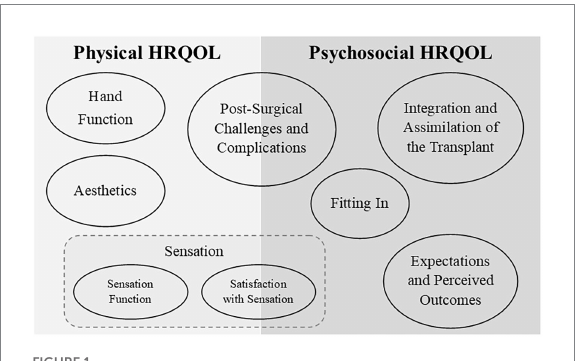
FIGURE 1 The eight new HRQOL content domains are presented above— represented by ovals—grouped into the overarching area of physical and psychosocial HRQOL under which they fall. In the area of physical HRQOL, three domains relevant to satisfaction with transplant were identified: Hand Function, Aesthetics, and Sensation. Sensation was further subdivided by separating Sensation Function from Satisfaction with Sensation. One domain includes aspects of both physical and psychosocial HRQOL: Post-Surgical Challenges and Complications, which includes physical and emotional reactions post-surgically. Psychosocial HRQOL included reflection on past perspectives in light of the completed transplant (Expectations and Perceived Outcomes). The internal reactions to stigmatization or feelings of self- acceptance (Integration and Assimilation of the Transplant) were separated from the external experience of stigmatization/ acceptance within the social context (Fitting